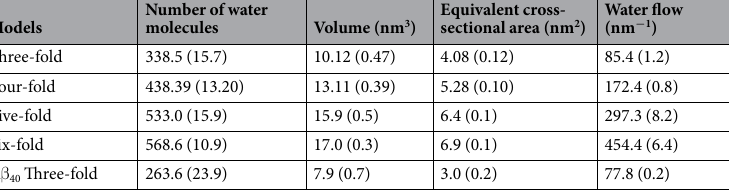
All of our models are built out of six layers. The height of fibrils along the z-axis (shown in Fig. 9a) are similar in all models. For example, the average height of fibrils in three-fold models is about 2.5 nm, where we define the height as the average distance between corresponding carbon-alpha atoms of residues in the first and sixth layer. The average distance between two peptides in our models is about 5 Å, which is a common value for the distance between the main chains of two peptides in a parallel β -sheet. Since the cross-sectional area is not regular, it is hard to calculated it directly. Instead, we have estimated the volume of the pores from the number of water mole- cules number inside it (shown in Table 4), assuming that the average occupied volume of each water molecule is about 2.99 × 10 − 2 nm 3 at room temperature, and divided the so-calculated volume by the height of the fragment to derive the equivalent cross-sectional areas that are shown in Table 4. Note that the diameters of the pores in our models are larger than some of the ion channel, for example, that of potassium channels which are about 1.2 nm 29, 30 , suggesting water leakage through such fibrils inserted in cell membranes as a possible toxicity mechanism. If such N-fold fibrils insert themselves into the membrane, they